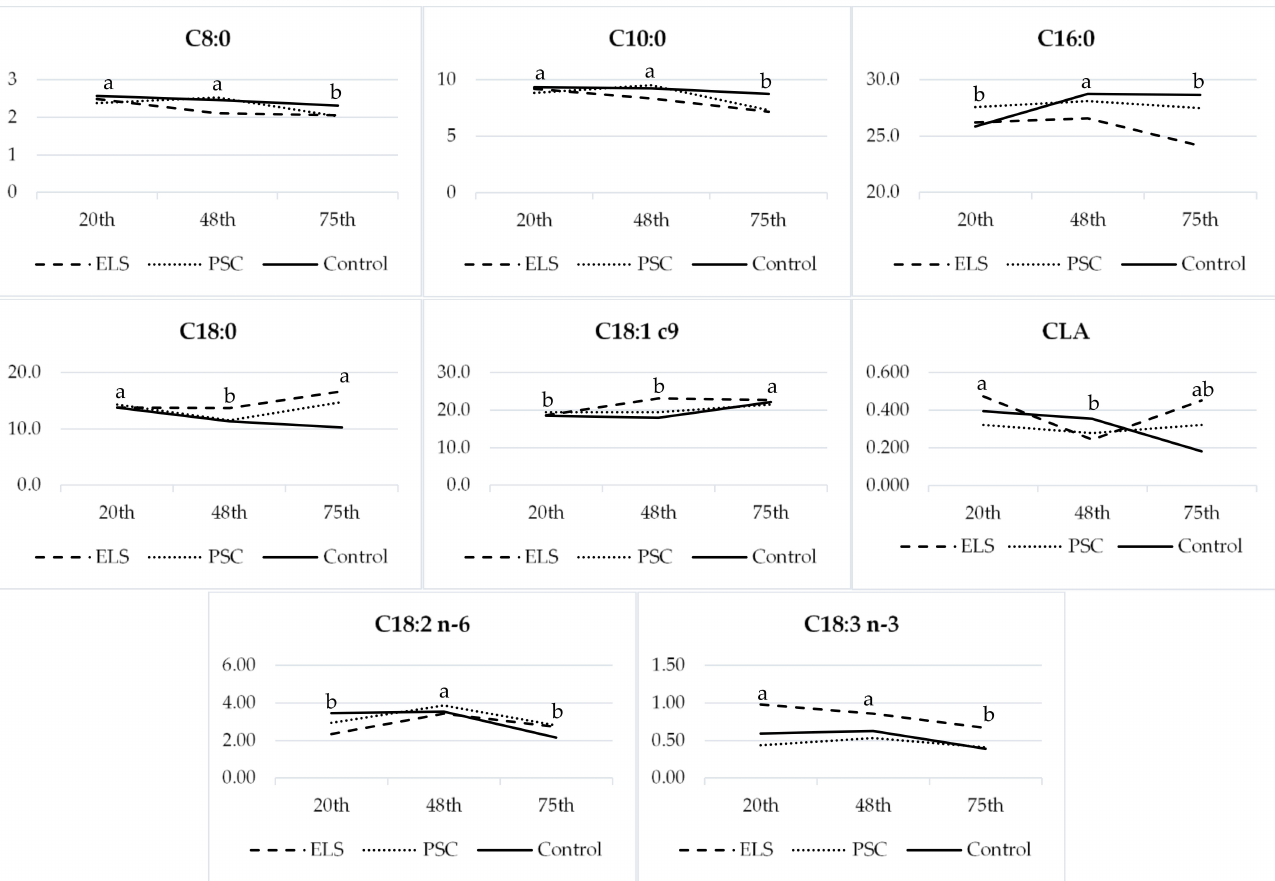
Figure 3. Fatty acids (g/100 g FAME) of semi-hard cheeses influenced by study period (32nd, 60th, and 87th day of lactation) of goats fed feed mixtures containing extruded linseed (ELS) or pumpkin seed cake (PSC). a, b, c Values with different superscripts differ significantly at p ≤